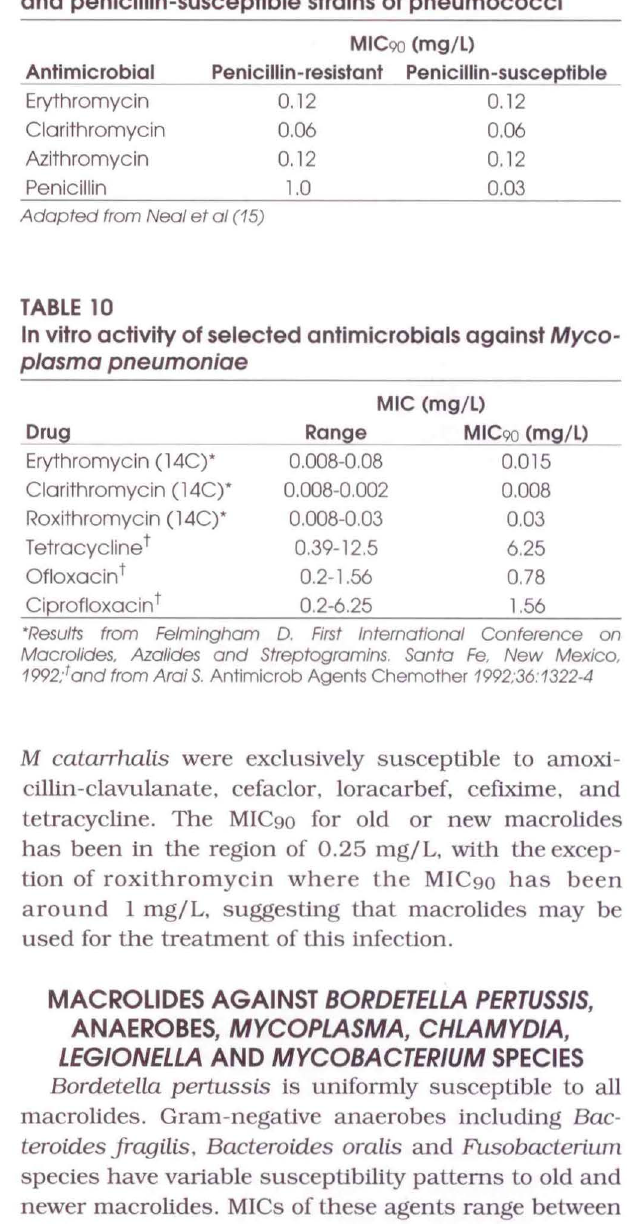
In vitro activity of selected antimicrobials against